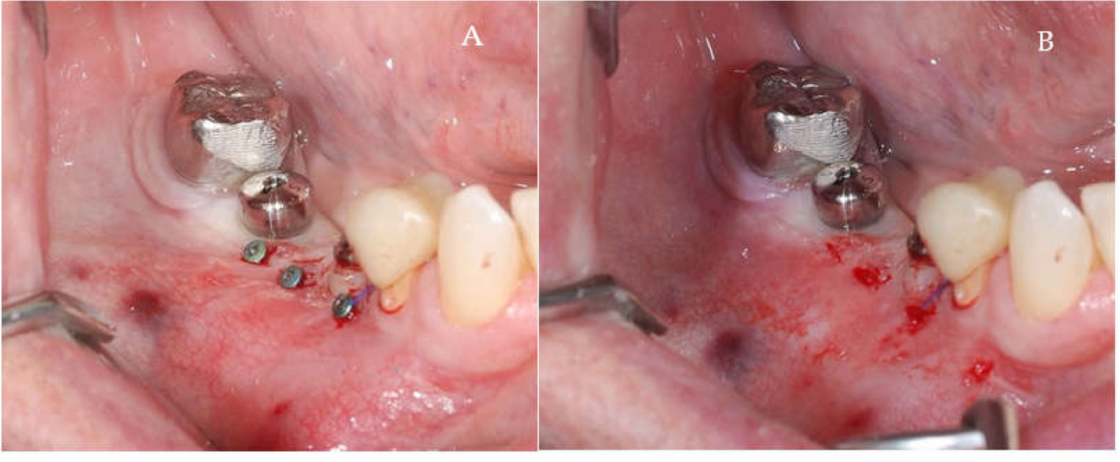
Figure 8. ( A , B ) Clinical aspects at the second stage surgical session. ( A ) Aspect before screw removal. ( B ) Aspect after screw